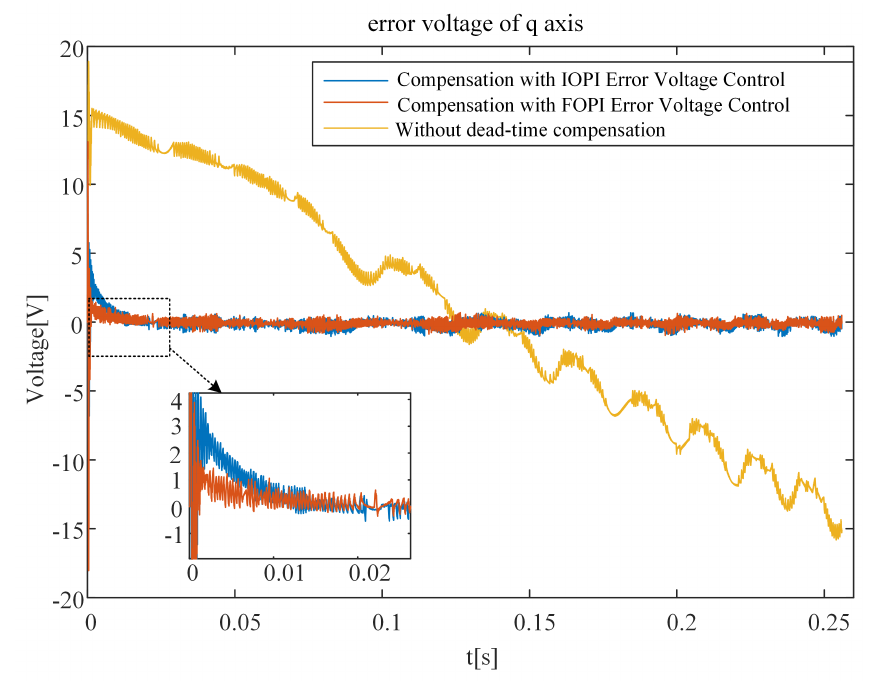
Figure 16. Comparison of the error voltage of q-axis. The d-axis voltage error simulation results are shown in Figure 17. It can be seen that the d-axis error voltage fluctuates significantly under the influence of the dead-time effect, and the dead-time compensation method with optimal FOPI error voltage control can substantially reduce the d-axis error voltage.